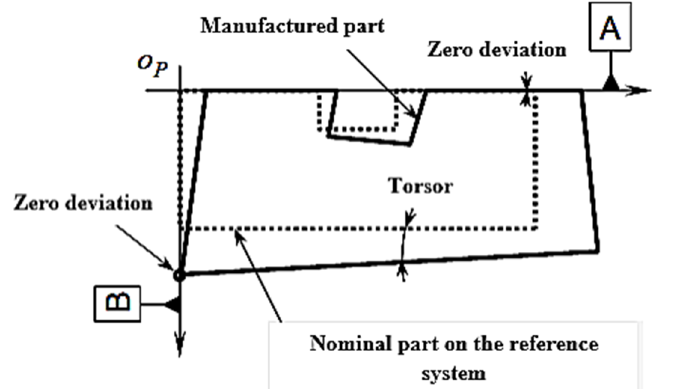
Figure 7. Nominal part associated to reference system.